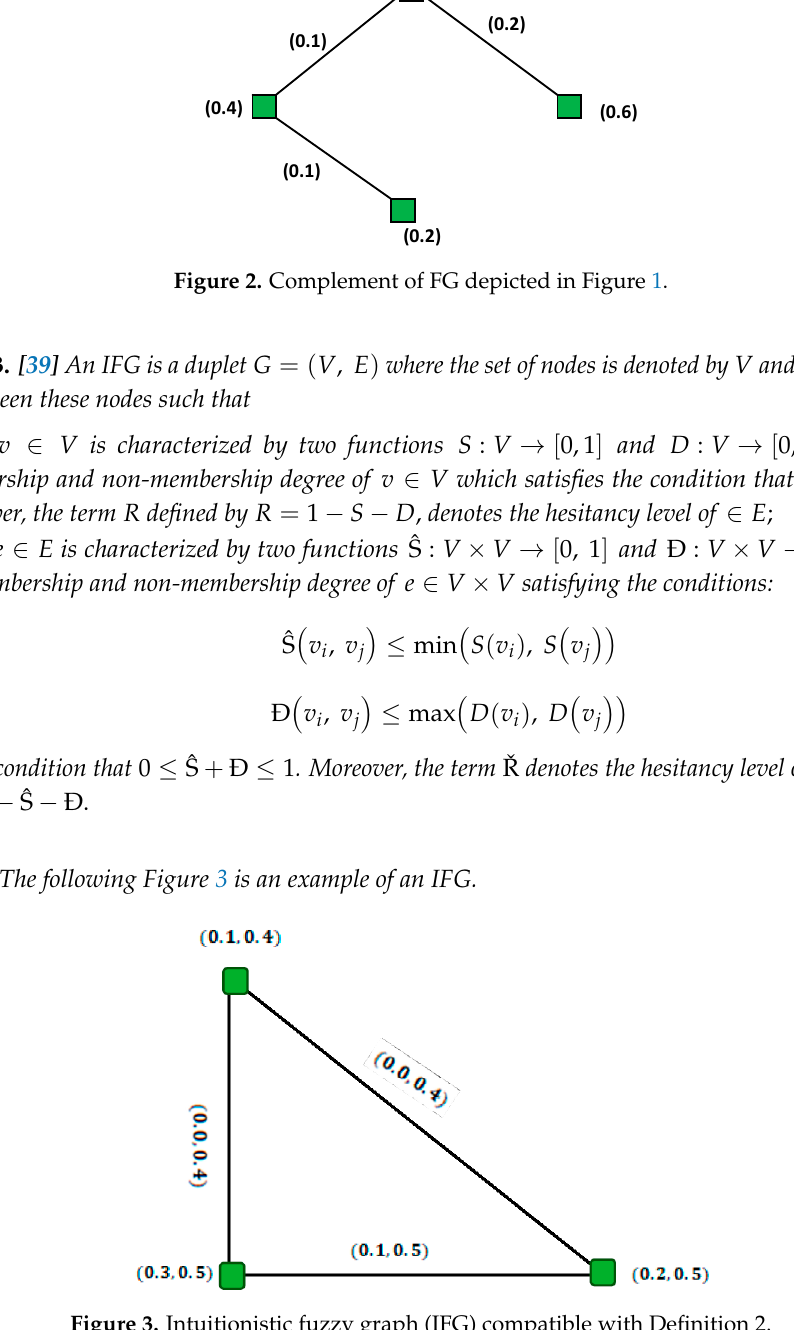
Figure 1. Fuzzy graph (FG) compatible with Definition 1.